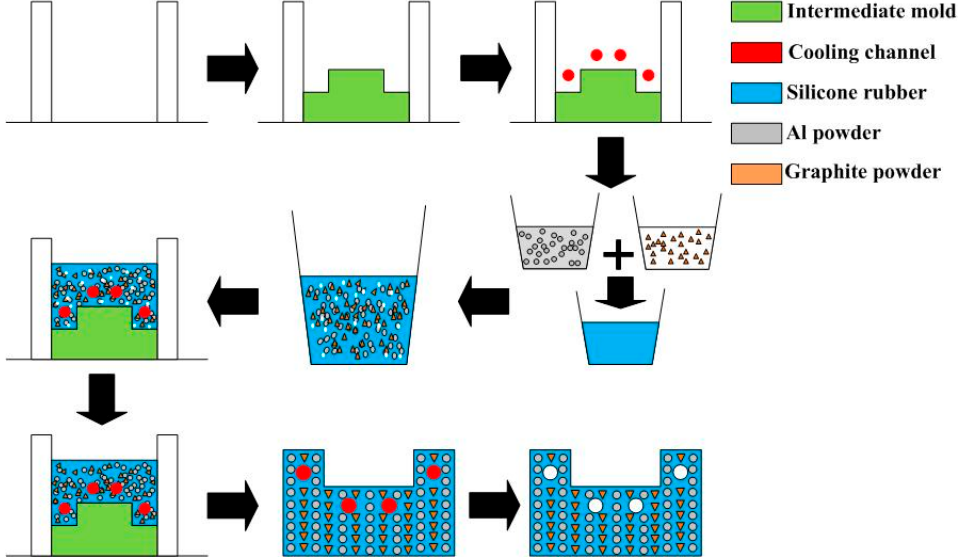
Figure 3. Schematic illustrations of the production process of a high cooling efficiency low ‐ pressure injection mold with CCC.